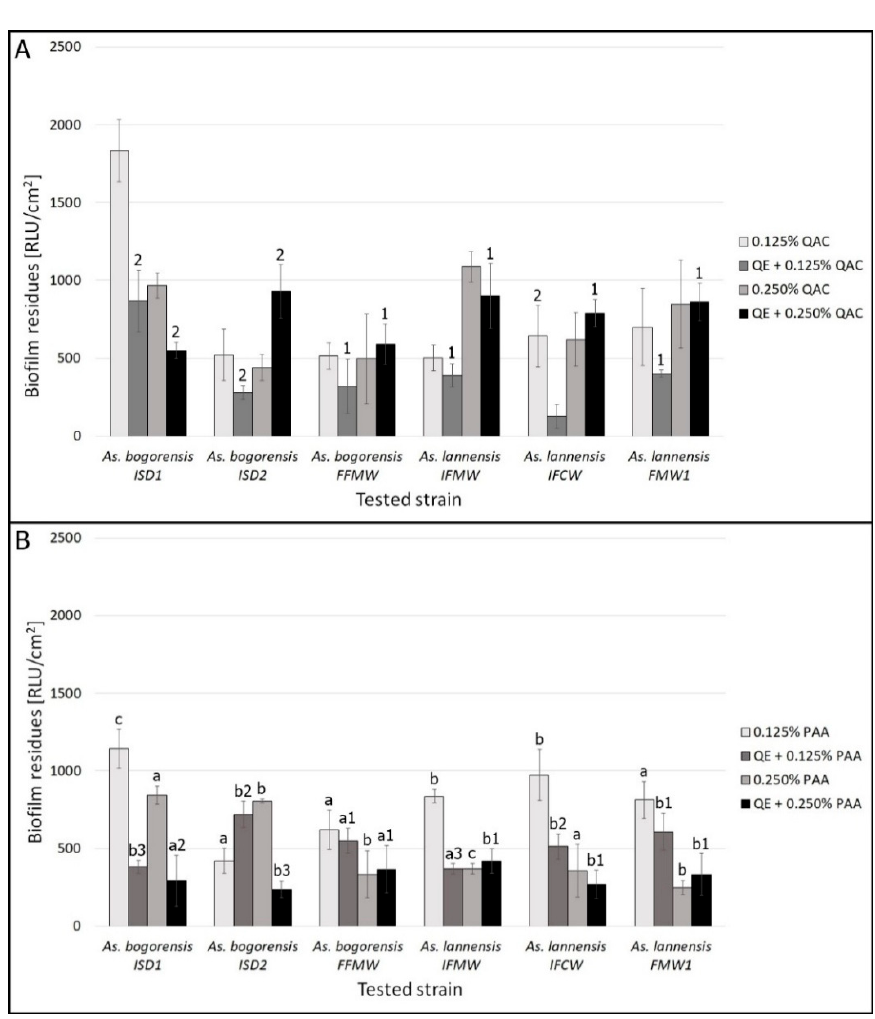
Figure 3. Effect of mature biofilm eradication by disinfectants: ( A ) N ‐ ethyl ‐ N , N ‐ dimethylhexadecylammonium bromide (QAC) and ( B ) peracetic acid (PAA) acting alone or in a combined action with Q. saponaria extracts (QE). Luminometric method (RLU/cm 2 ). Values with the different superscript lowercase signs are statistically different ( p < 0.05). Lowercase letters for PAA results compared to those for QAC: a p > 0.05; b 0.001 < p < 0.05; c p < 0.001. Lowercase numbers for disinfectant results compared to those for QE+ disinfectant: 1 p > 0.05; 2 0.001 < p < 0.05; 3 p < 0.001.